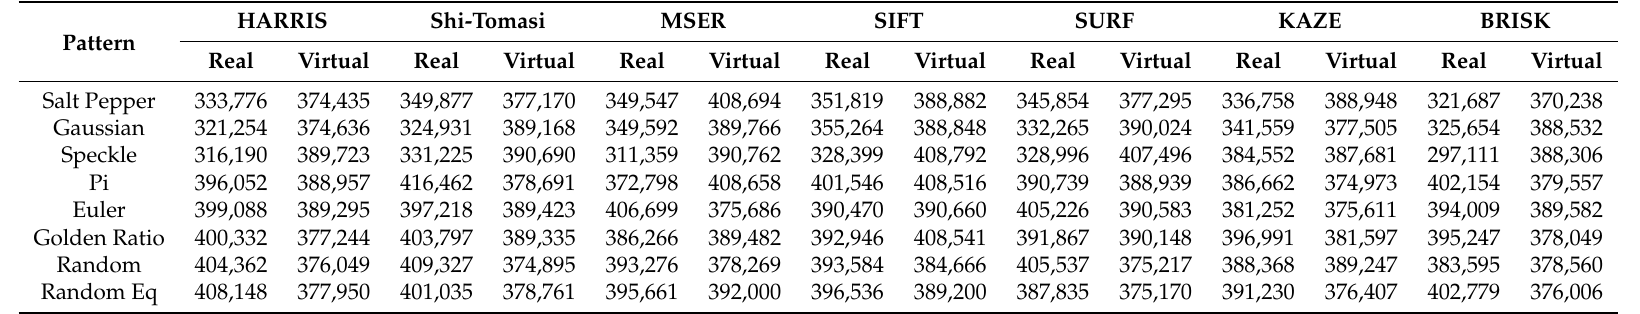
Table 1. The number of vertices found in the dense point clouds of planar surface reconstruction.